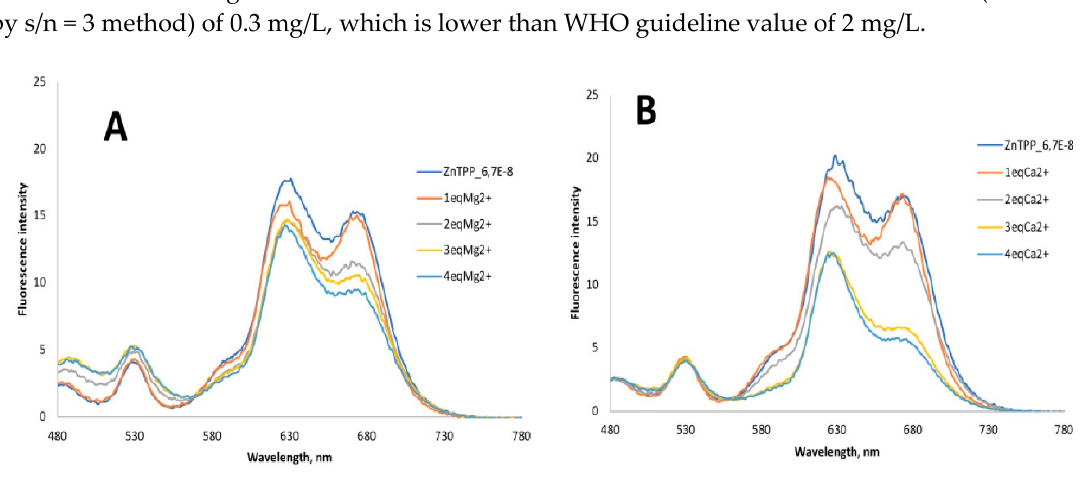
Figure 2. The fluorescence response of 6.7 × 10 − 8 M ZnPC in THF upon addition of 1, 2, 3 and 4 equiv. of ( A ) Mg 2+ and ( B ) Ca 2+ ions; λ ex = 460